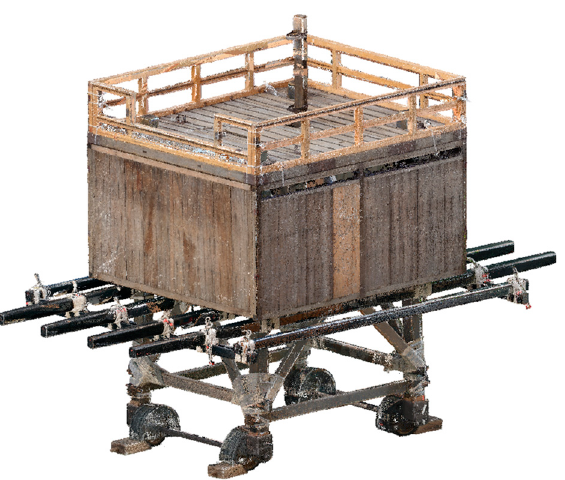
Figure 16. 3D-laser-scanned point cloud of the Hachiman-Yama float used in the Gion Festival in Kyoto City, Japan (7,866,197 points).